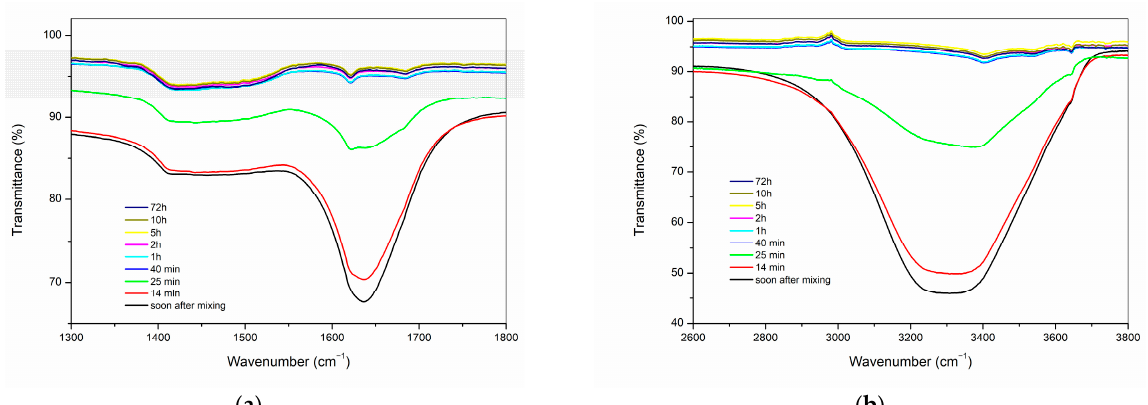
Figure 7. ATR-FTIR spectra of the ProRoot MTA paste at selected time intervals following mixing shown in the regions ( a ) 1300–1800 cm − 1 ; ( b ) 2600–3800 cm − 1 .